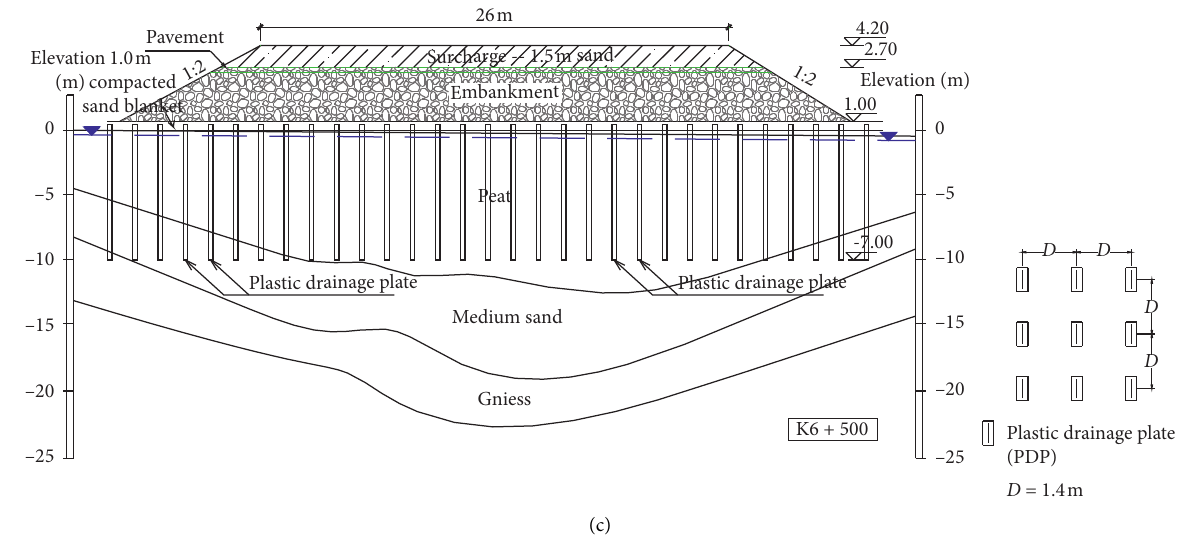
Figure 4: Schematic of the ground improvement method of sand piles, gravel piles, and plastic drainage plate as prefabricated vertical drains. (a) K2+ 600; (b) K4+900; (c) K6 +500 (cross-station).